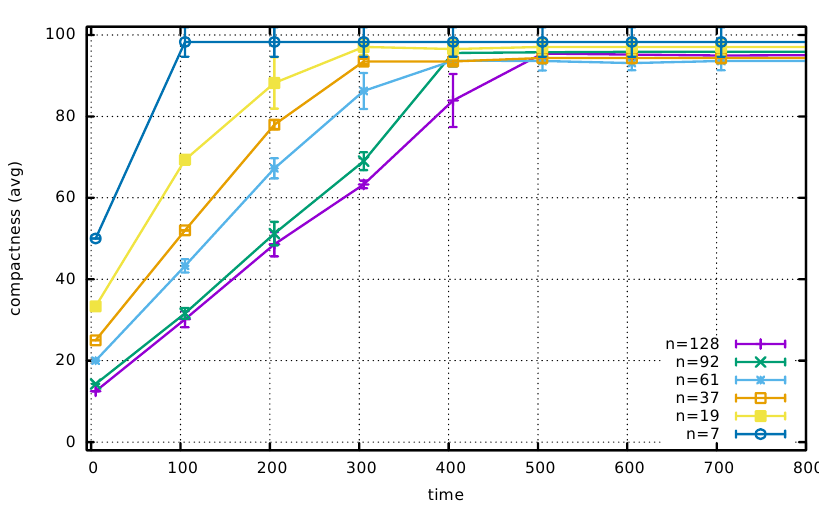
Fig. 4: Average compactness along time for different number of nodes.